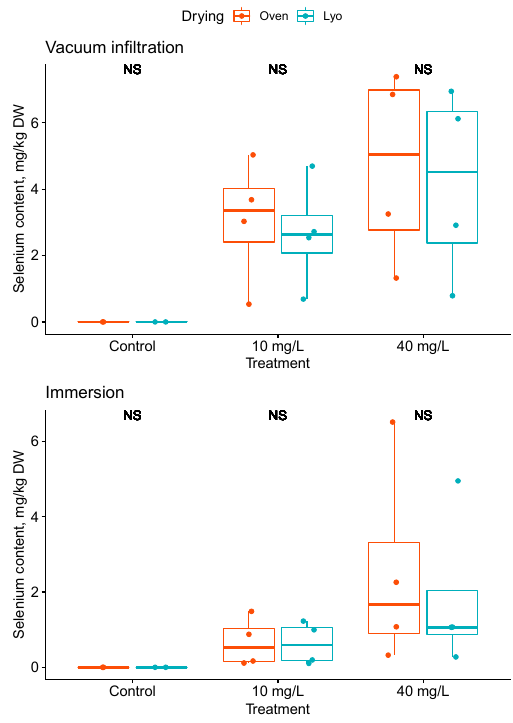
Figure 6. Content of Se in tomato fruit treated under a vacuum (top) and passive immersion (bottom) at 0, 10, and 40 mg Se L − 1 in the form of sodium selenate. Orange bars represent results from analysis of the samples dried in an oven, blue bars indicate results collected from lyophilized tissue (Lyo). Values are the means ± SE ( n = 3). Values with the same letter on the same date are not statistically different ( p ≤